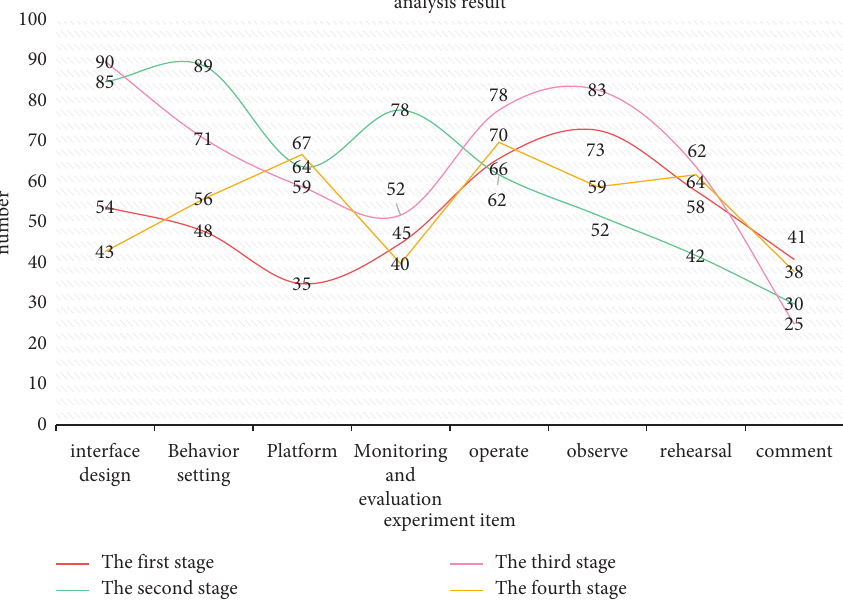
Figure 4: Four-stage student satisfaction evaluation and analysis results of the college physics experiment Table 3: Comparison of facial expression recognition rate.